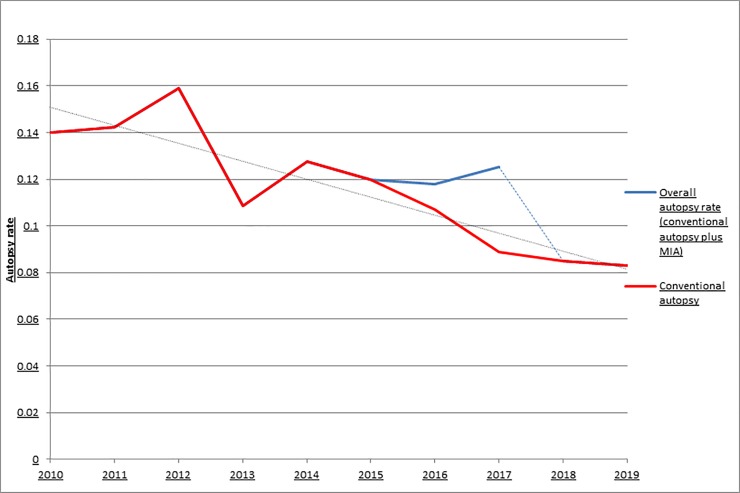
Autopsy rates 2010–2019.The overall autopsy rate consists of the combination of the autopsy rates of conventional autopsy and minimally invasive autopsy. The blue dashed line represents the return of the autopsy rate to the trendline after the minimally invasive autopsy was no longer available in our hospital.